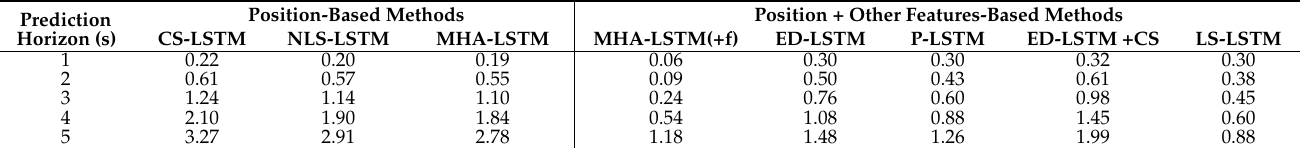
Table 1. RMSEs in meters over a 5 s prediction horizon for the proposed and baseline models. Prediction Horizon (s)